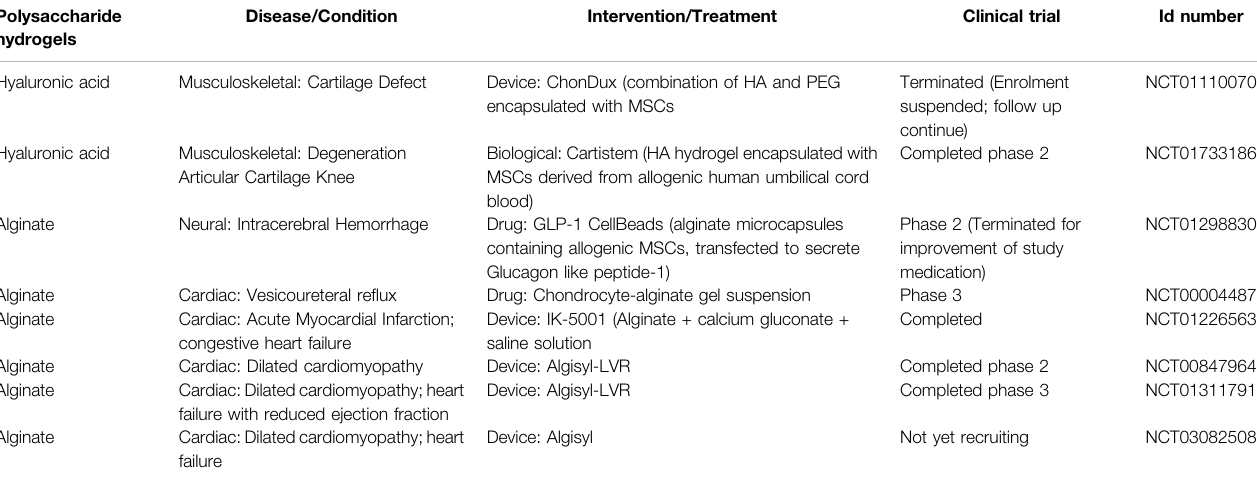
TABLE 2 | Clinical trials using polysaccharide hydrogels with/without stem cells as of January 2021 (ClinicalTrials.gov). Polysaccharide Disease/Condition hydrogels